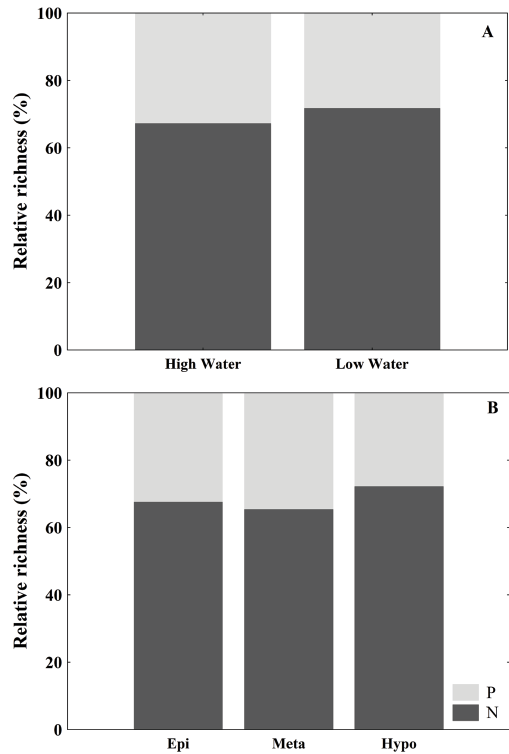
Figure 7. Relative species richness (%) of planktonic (P) and non-planktonic (N) ciliates in two hydrological periods (A) and three different strata (B) in the Guaraná Lake. Epi=Epilimnion, Meta=Metalimnion,